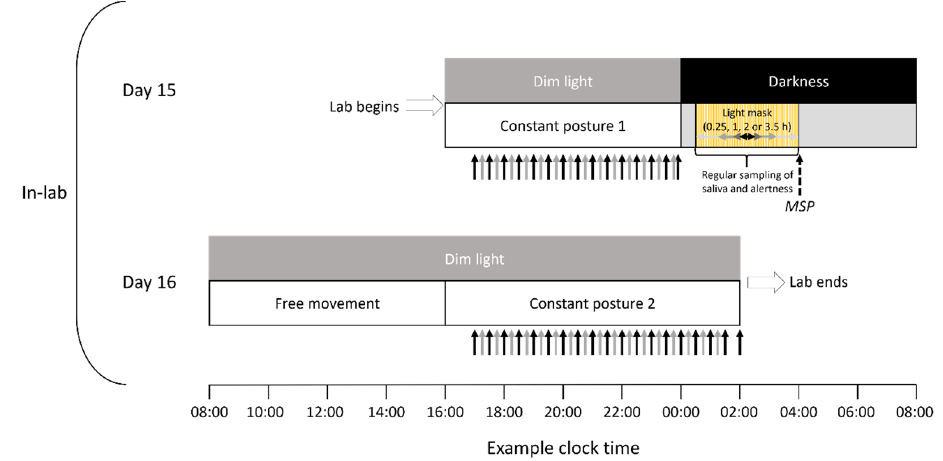
Figure 2. Timing of the laboratory protocol. After stabilizing their sleep/wake rhythms for fourteen days, participants attended the laboratory for a controlled study of the effect of stimulus duration on circadian rhythms. Upon admission to the laboratory on Day 15, participants remained in dim light (<2 lux) during constant posture, regularly provided saliva samples (solid black arrows), and were tested for objective and subjective sleepiness (solid gray arrows). Room lighting was extinguished 4 h prior to the midsleep phase (MSP, dashed black arrow) to provide a sleep opportunity. During the biological night, participants were awakened and exposed to a sequence of light flashes via a light-emitting eye mask. Light exposure lasted for either 0.25, 1, 2, or 3.5 h, and consisted of 2-millisecond flashes of ~2200 lux white light, which were presented every 8 s. The stimuli were aligned such that their midpoints occurred at the same circadian time. On Day 16, participants were awakened at their habitual wake time under dim light, and were provided breakfast and lunch before entering constant posture to, again, provide measures of saliva and of objective and subjective alertness. Participants were discharged at the conclusion of constant posture 2.